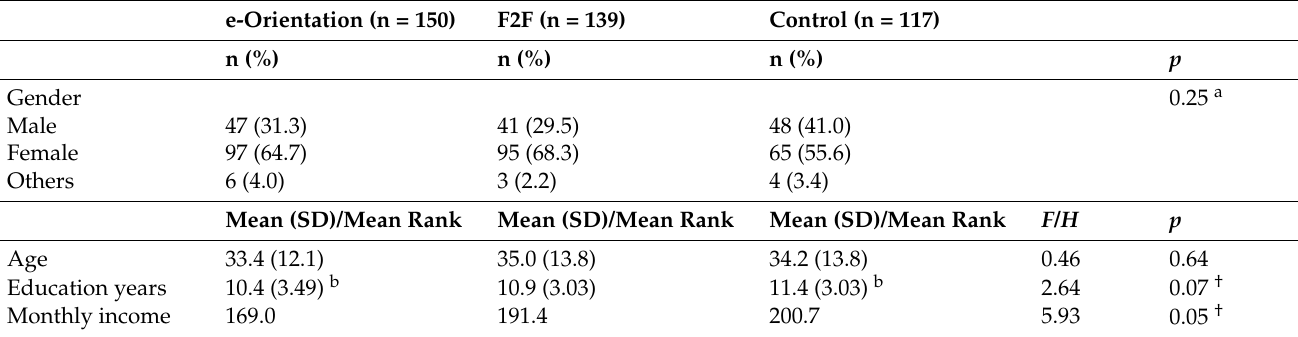
Table 1. Socio-demographic characteristics (n =